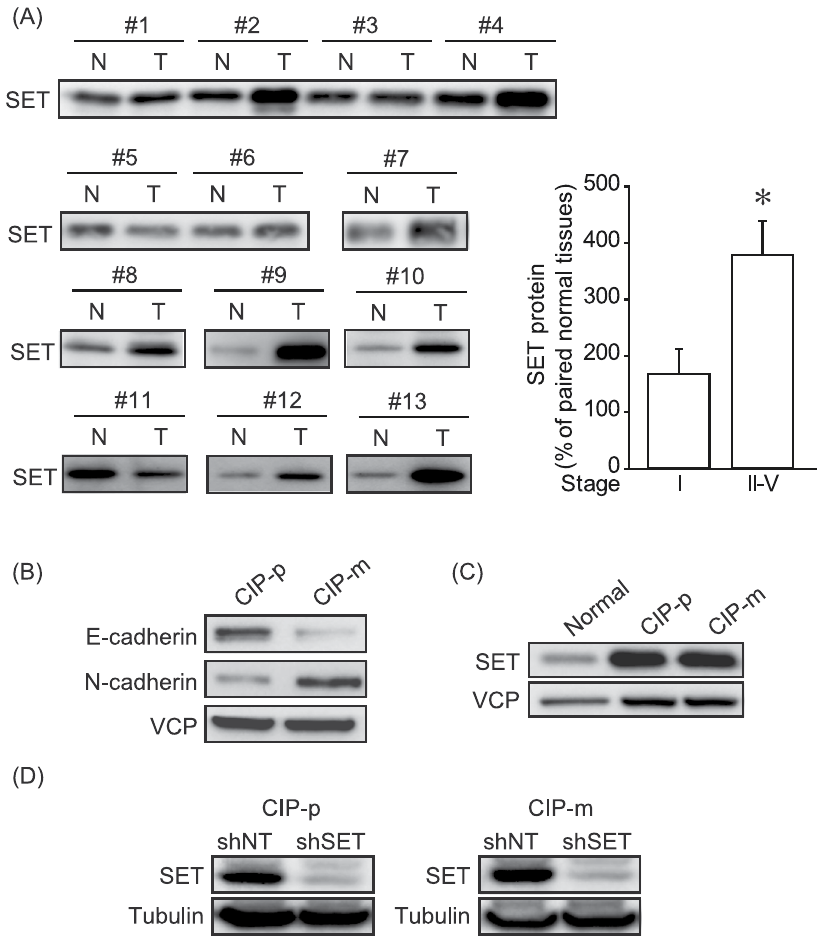
Figure 1. SET protein levels in canine mammary tumor tissues and cell lines. ( A ) 10 μ g of proteins of canine mammary tumor tissues and paired normal mammary gland tissues were subjected to analyze SET protein levels by immunoblotting. Band densities of cancer tissues were normalized to paired normal tissues as 100%. ( B ) EMT markers protein levels of canine mammary tumor cell lines were determined by immunoblotting. ( C ) SET protein levels of canine mammary tumor cell lines were determined by immunoblotting. Normal: normal mammary gland tissue. p97/VCP was used as a loading control. ( D ) The effects of non-targeting shRNA (shNT) and SET targeting shRNA (shSET) were determined by immunoblotting. Representative pictures from 2 independent experiments were shown. Tubulin was used as a loading